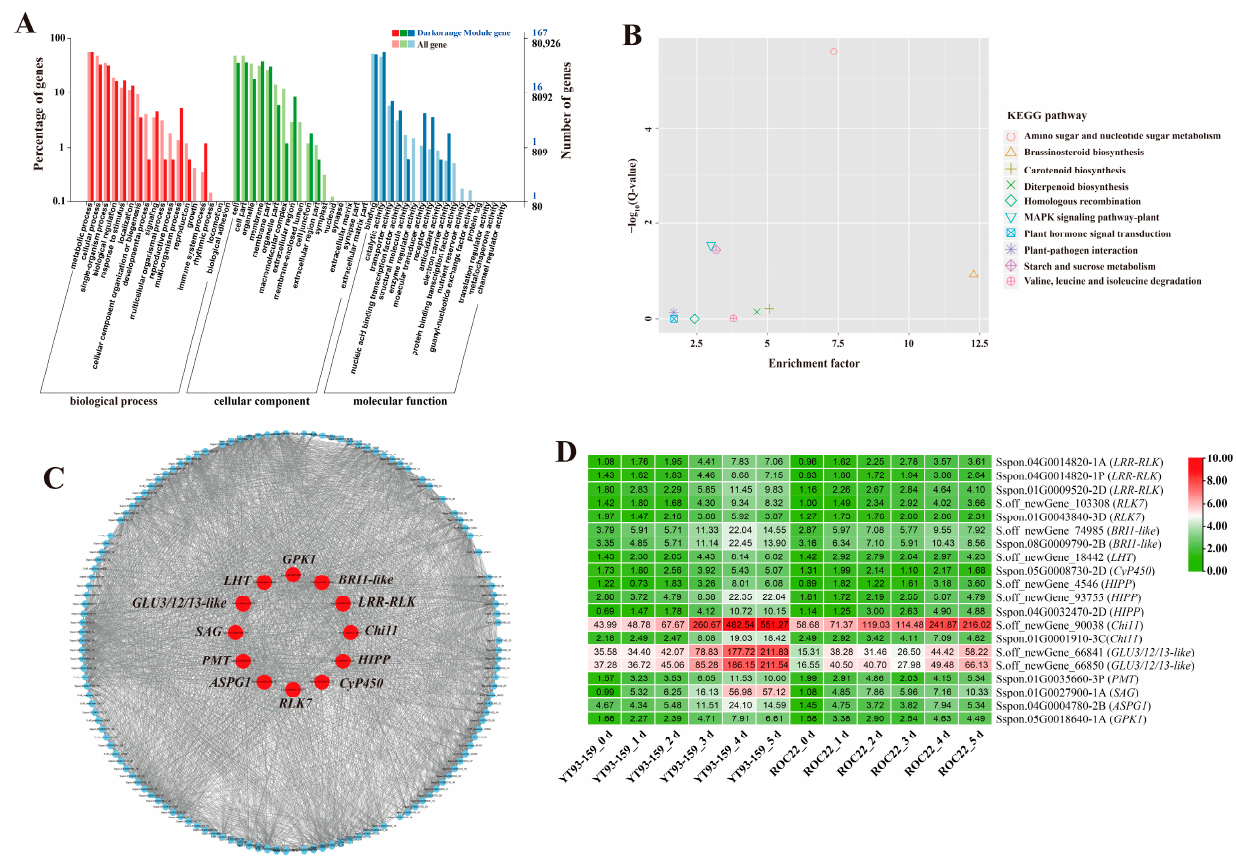
Figure 7. GO enrichment, KEGG enrichment, gene co-expression network and expression patterns of hub genes in the Darkorange module. ( A ) GO functional enrichment analysis. ( B ) KEGG functional enrichment analysis. ( C ) A gene co-expression network and hub genes. The red represents hub gene. Genes with a higher connectivity in the corresponding network are shown in larger circles. ( D ) Expression patterns of hub genes. YT93-159_0 d to _5 d and ROC22_0 d to _5 d represent YT93-159 and ROC22 at 0 d to 5 d post- S. scitamineum inoculation,